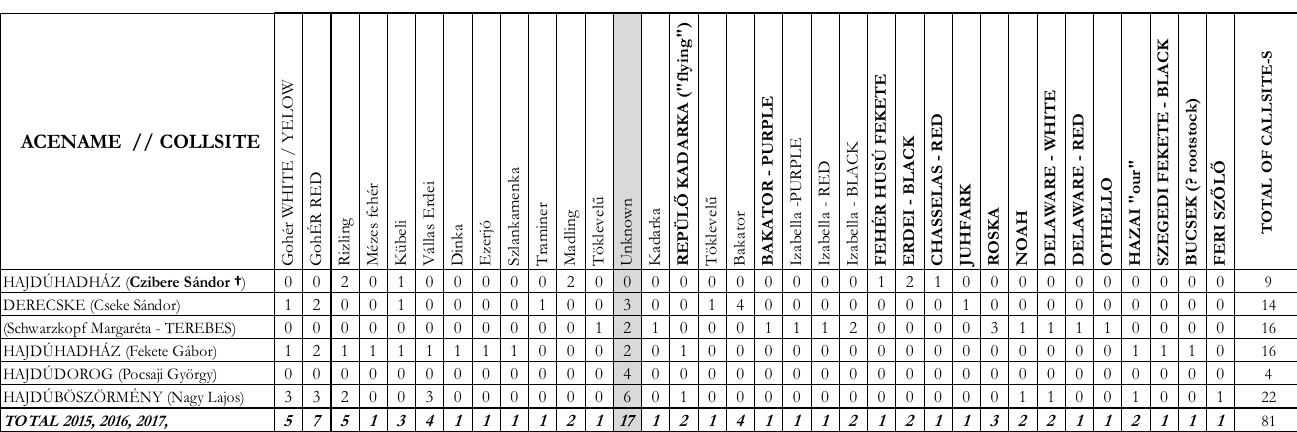
Table 3. Summary if ACENAME-s for each CALLSITE 2015-2017